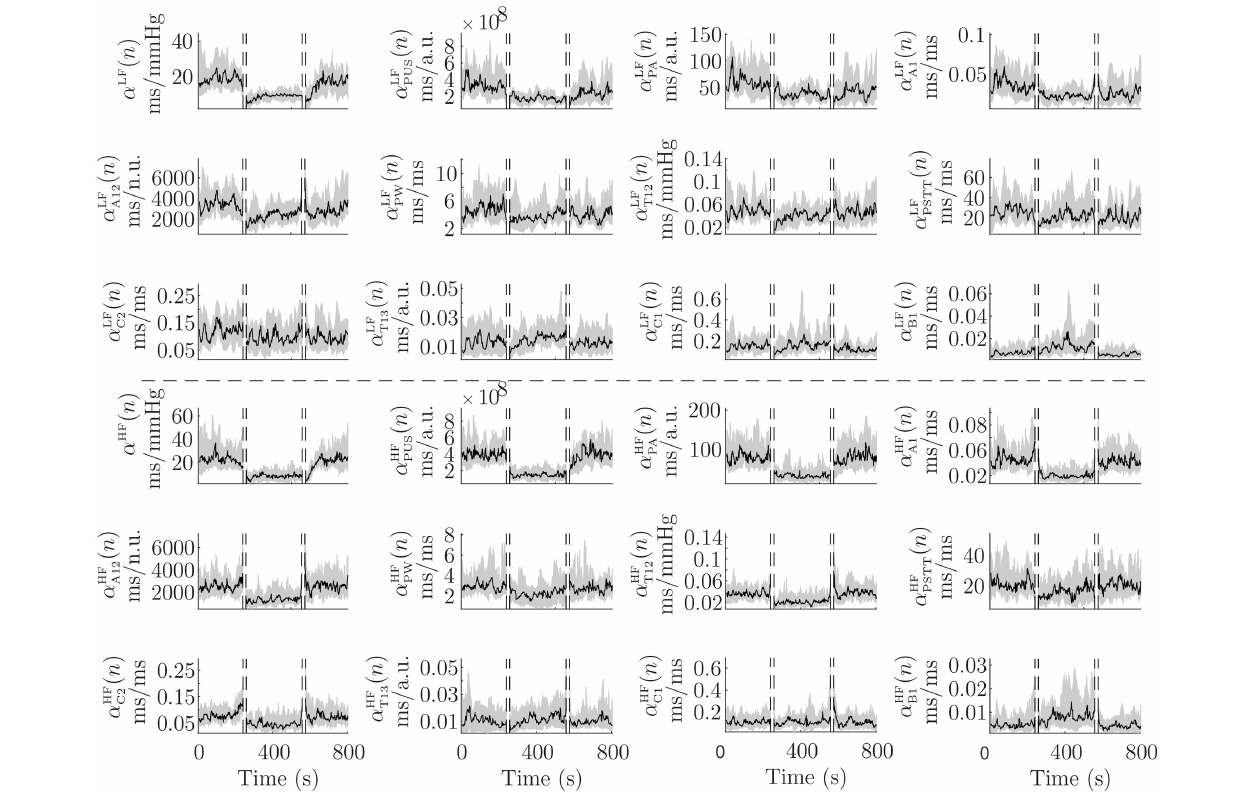
α HF γ ( n ), respectively, in this paper. Further details are given k in Orini et al.